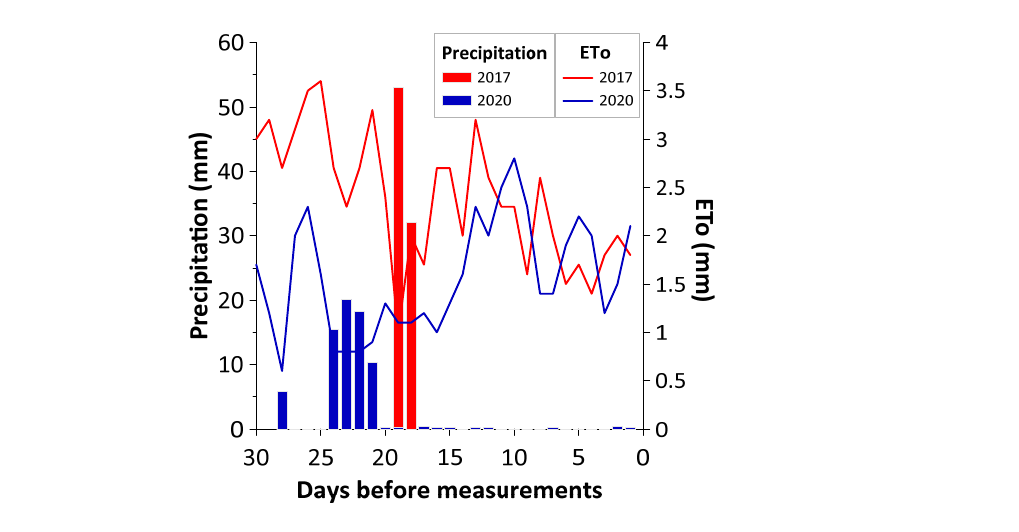
Figure 2. Daily rainfall and reference crop evapotranspiration (ETo) during the 30 days preceding the ECa measurements in 2017 and 2020.